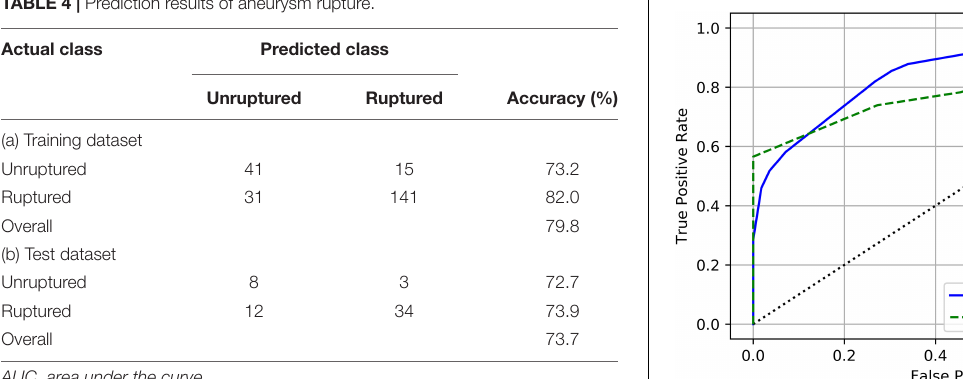
TABLE 4 | Prediction results of aneurysm rupture.